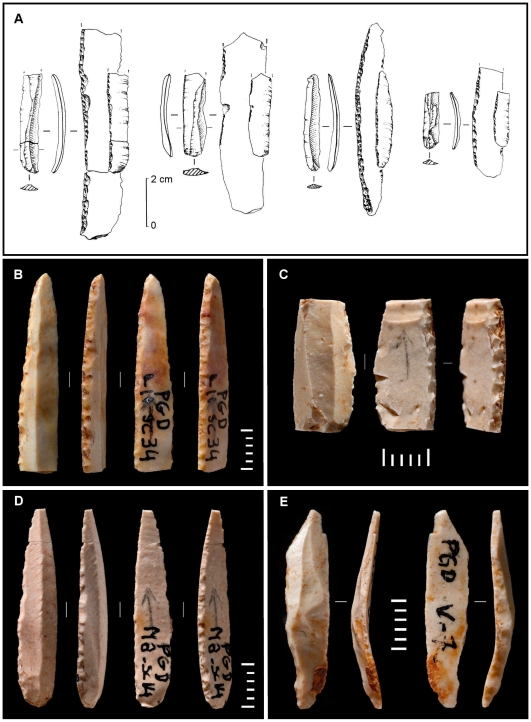
“Dufour bladelets”: Pego do Diabo compared with the Protoaurignacian.
A. Dufour bladelets from level VII of the Grotte du Renne, Arcy-sur-Cure (France) [77]; the ventral side is shown at 2×. B–E. Dufour bladelets from the Aurignacian III–IV of Pego do Diabo (all scales are in mm). The straight profiles, alternate retouch, pointed tips and impact fractures of the Pego do Diabo items set them apart from the Protoaurignacian Dufours, which feature curved profiles, marginal inverse retouch and obtuse tips.